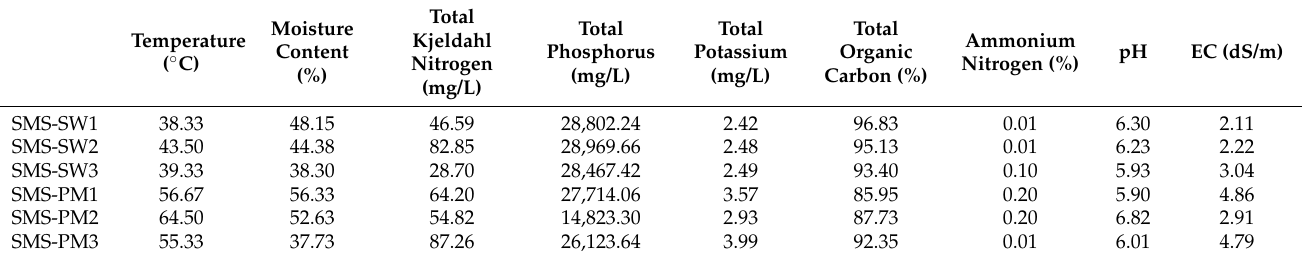
Table 1. Characteristics of physical-chemical during